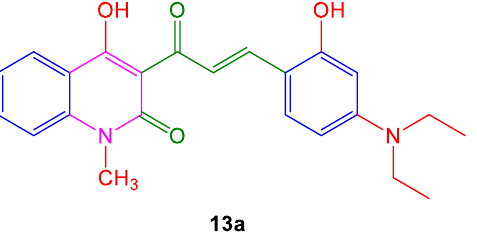
Figure 9. Structures of compounds ( 13a – b ).